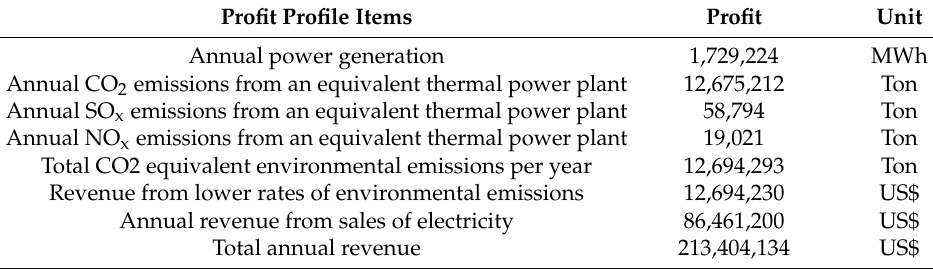
Table 4. Revenue of power generation estimated by HECAM II